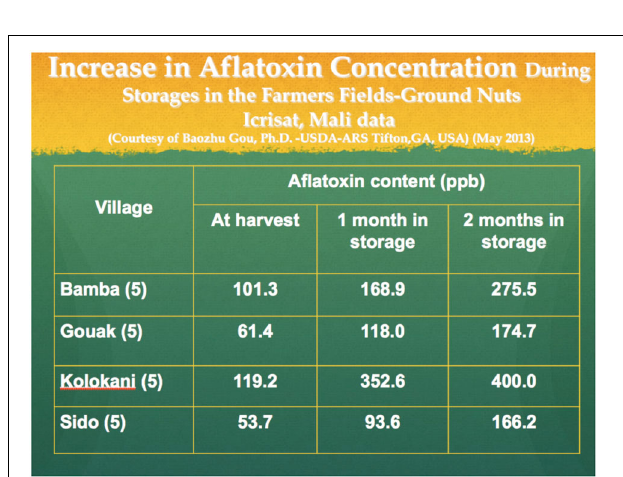
FIGURE 3 | Increase in aflatoxin concentration during storage in the farmers’